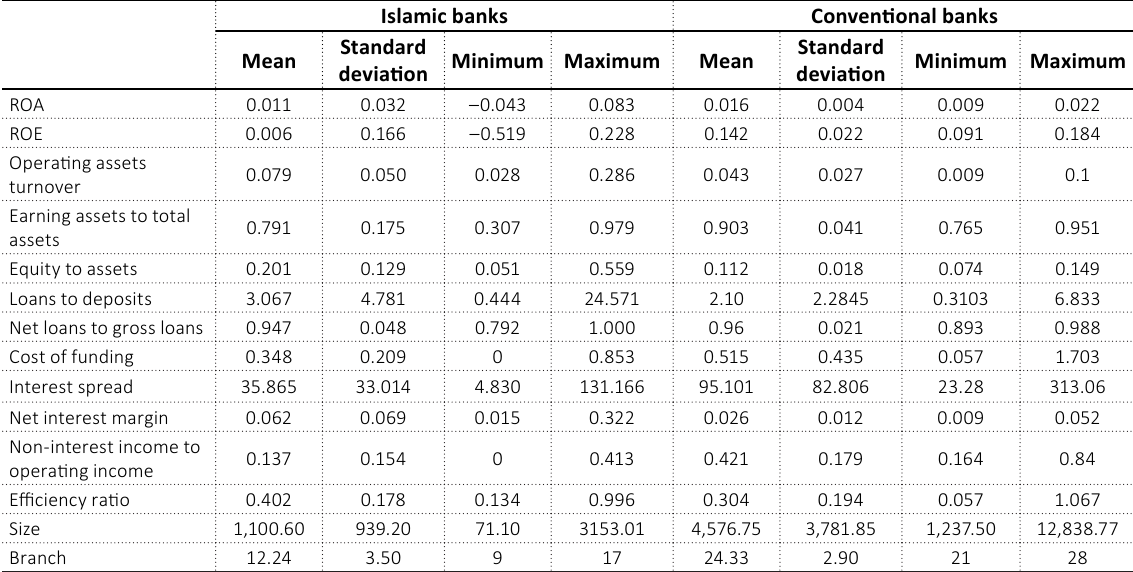
Table 1. Summary statistics of independent variables and their impact on bank